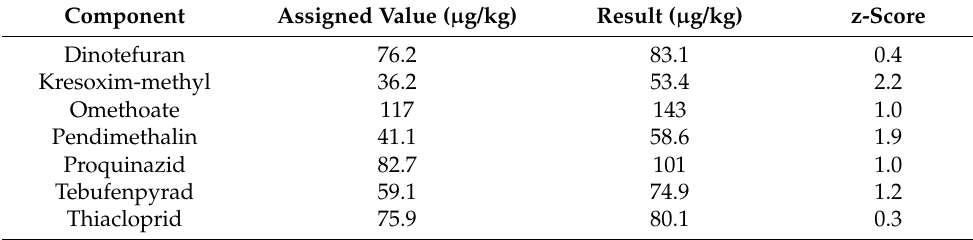
Table 3. Apple pur é e, proficiency test 19,307 (FAPAS), March